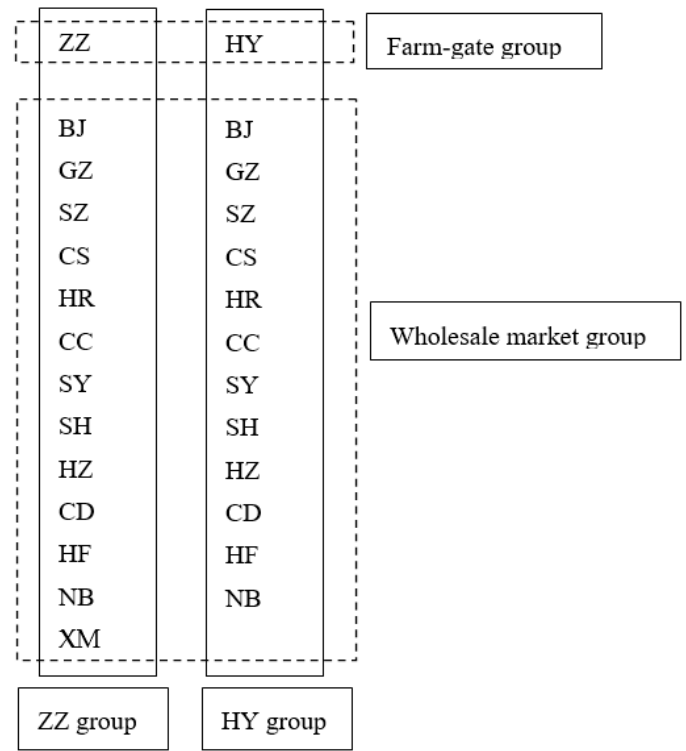
Figure 2. The explanation of each group.